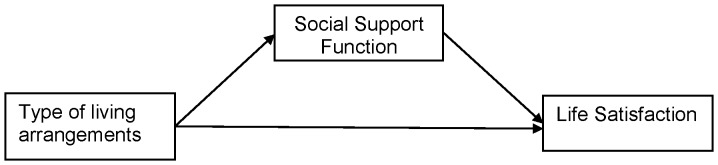
Conceptual framework mediating role of social support function on relation between type of living arrangements and life satisfaction.